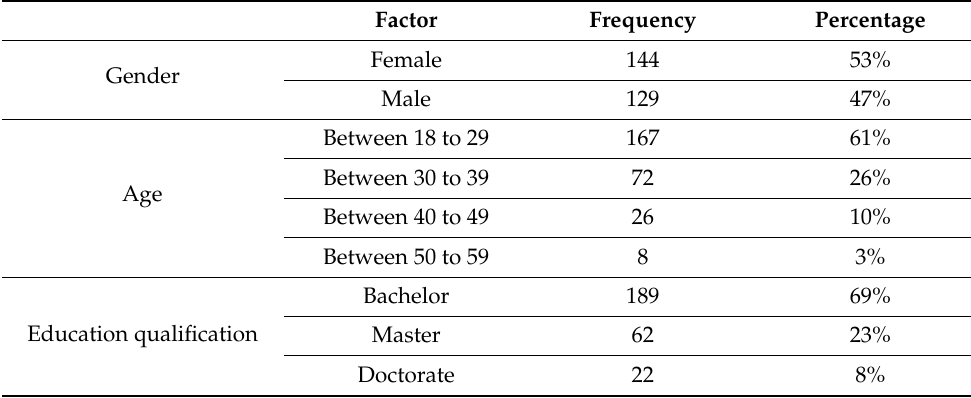
Table 2. Demographic data of the